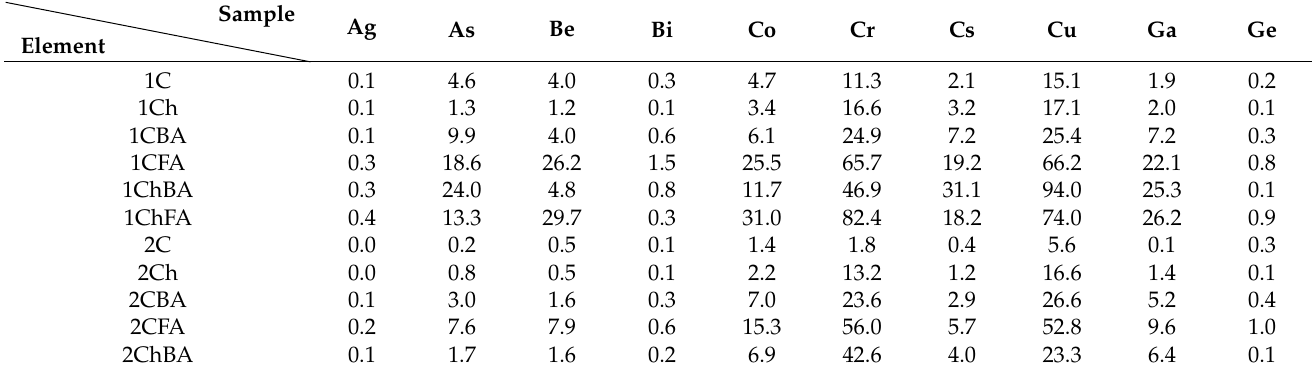
Table 2. Critical raw materials in coal, chars, and